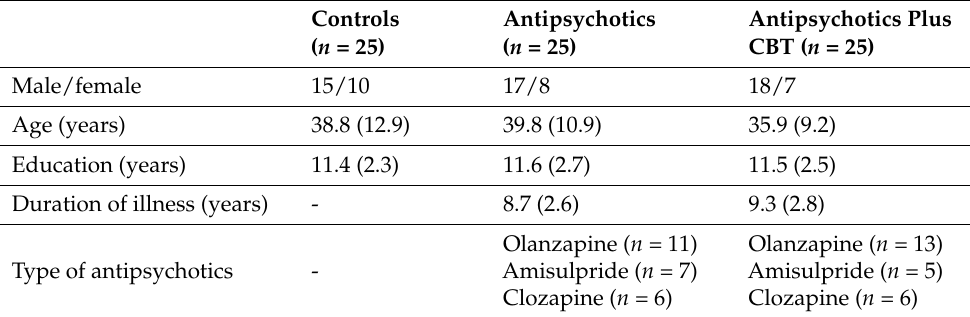
Table 1. Demographic and clinical characteristics of the participants.